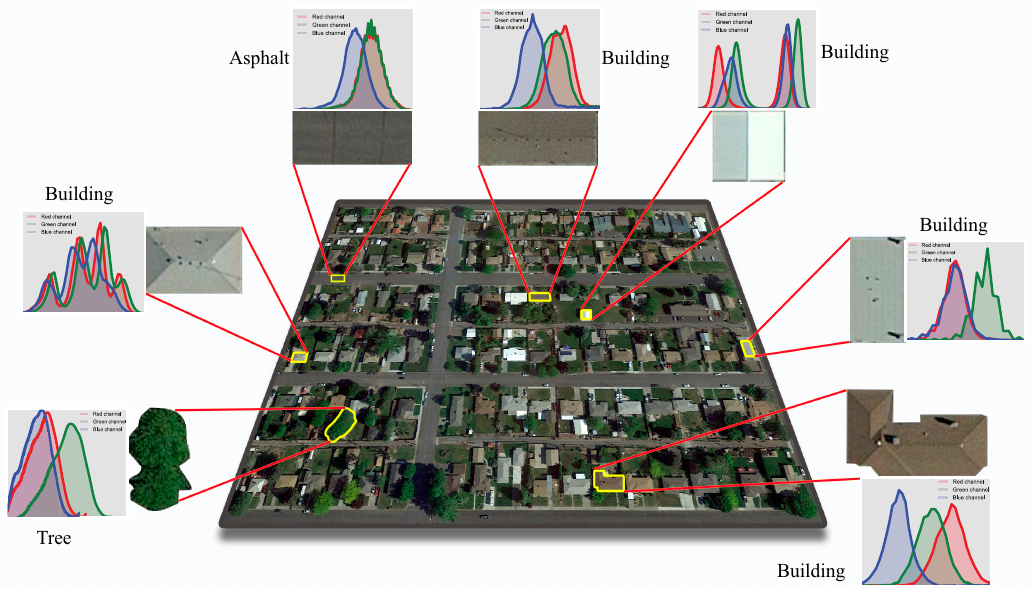
Figure 1. Varying spectra of different land covers over a given urban area. Note: The colors in the spectra diagrams show the distributions (histograms) of red, green, and blue bands.